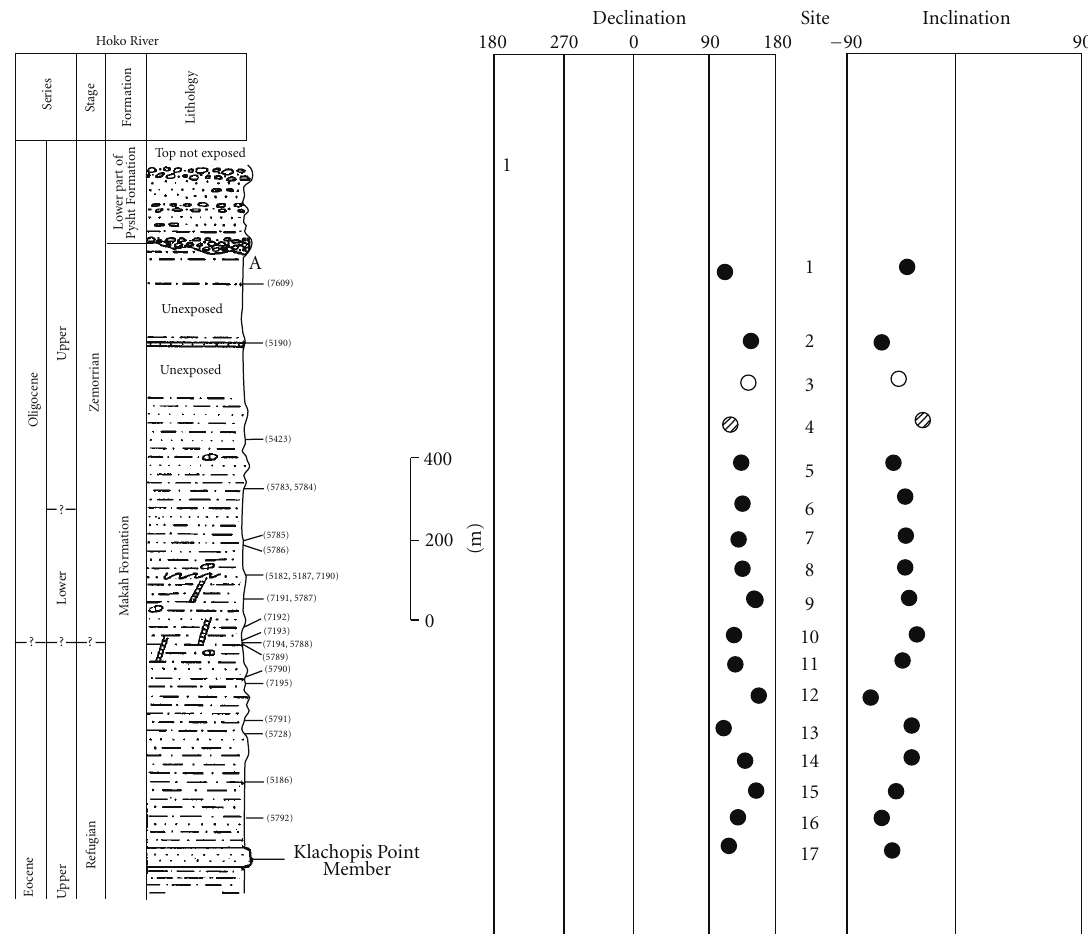
Figure 8: Magnetic stratigraphy of the coastal section between Shipwreck Point and the mouth of the Sekiu River. Conventions as in Figure